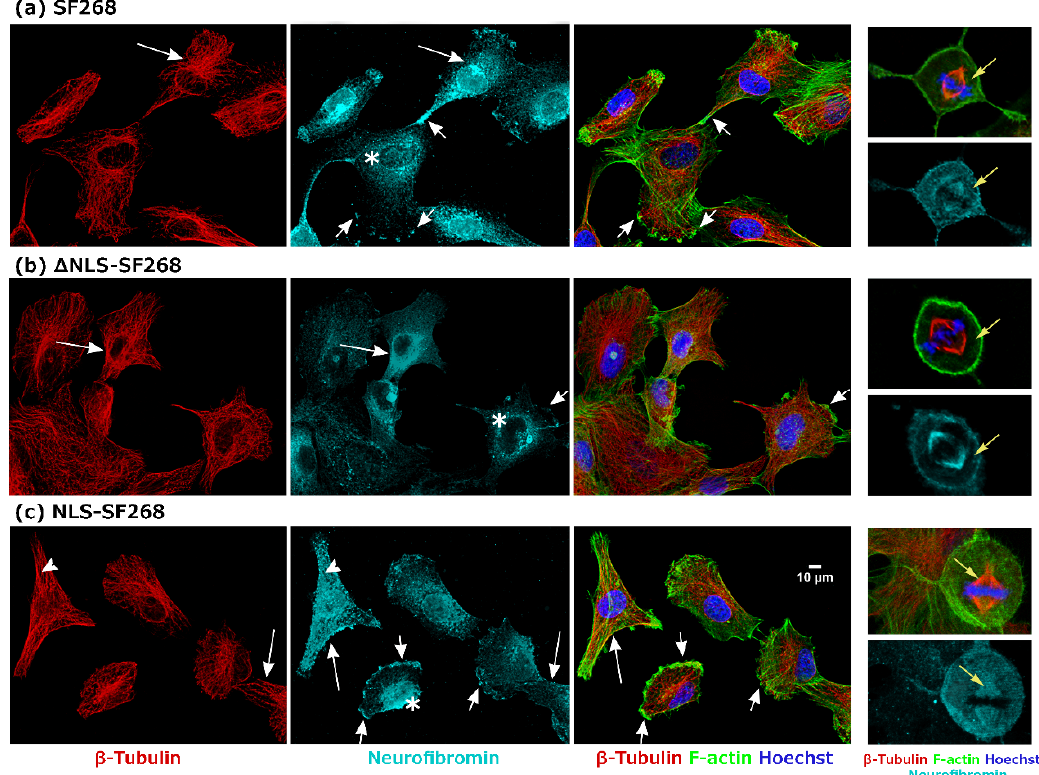
Figure 1. Subcellular localization and co-localization with β-tubulin or F-actin of endogenous neurofibromins differ in cells genetically modified with shRNA knockdown of non-NLS or NLS NF1 transcripts and express either ΔNLS or NLS neurofibromin, respectively. Asynchronous cells, treated with the cross-linker DSP, extracted with Triton X-100, and fixed with PFA, were quadruply stained for β-tubulin (red), neurofibromin (cyan), F-actin (green), and chromatin (blue), as described in Methods. Panels show representative confocal deconvolved images at interphase (first three columns) and at metaphase (last column) of ( a ) SF268 naïve cells, ( b ) ΔNLS-SF268 cells, and ( c ) NLS-SF268 cells. Detailed description is provided in the text. Images are the maximal intensity projection of 0.34 μm confocal planes that include all F-actin and β-tubulin signals; representative single planes and corresponding fluorochrome correlation scattered plots are presented in Supplementary Figure S2. Moreover, in cells depleted of NLS neurofibromins and thus expressing only ΔNLS neurofibromins (ΔNLS-SF268), association of neurofibromin with F-actin was significantly limited, especially in lamellipodia that appeared less developed, as well (Figure 1b, small arrow and Table 1). In contrast, in their counterpart NLS-SF268 cells, the NLS-neurofibromin richly decorated their well-formed lamellipodia and significant increases of association with F-actin were recorded (Figure 1c, small arrows and Table 1). Association with tubulin was not significantly reduced in ΔNLS-SF268 cells, yet neurofibromin localization appeared more diffused without the typical fibrillar patterns and perinuclear concentrations (Figure 1b, long arrows and Table 1). Notably, a cytoplasmic MTOC was not readily recognized and MTs organized a dense yet non-radial network of often parallel fibers, with significantly increased β-tubulin intensity (Table 1). To the contrary, NLS neurofibromin colocalization with β-tubulin was significantly enhanced (NLS-SF268; Figure 1c, arrowheads; Table 1), while β-tubulin intensity was not affected (Table 1). Both types of neurofibromins retained colocalization with β-tubulin on the mitotic spindle (Figure 1, yellow arrows in far-right column panels and Supplementary Figure S2d), albeit colocalization levels with NLS-neurofibromin were significantly raised, as also seen with MTs in the cytosol (Table 1). Taken together, these data showed that NLS-neurofibromins exhibit greater affinity for spindle MTs and for cytosolic MTs without affecting their density, whereas ΔNLS-neurofibromins, exhibiting lesser affinity for cytosolic MTs, inversely regulated MT densities in the cytoplasm.